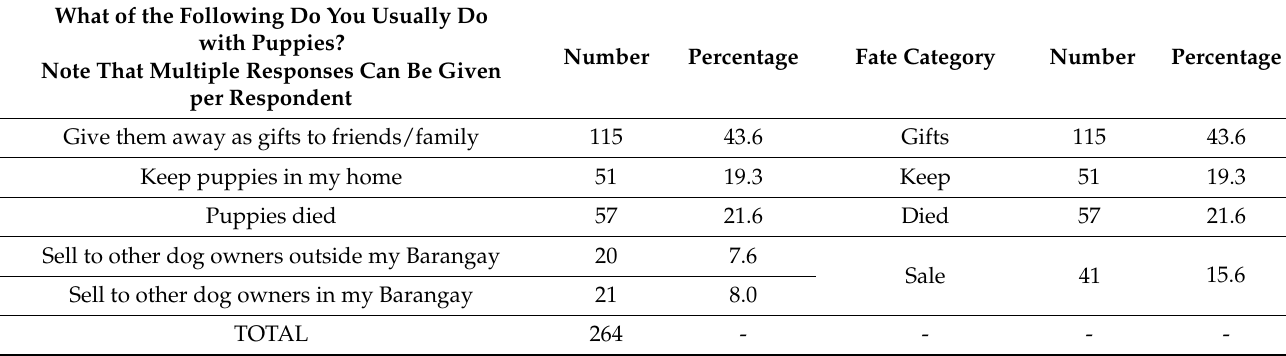
Table 5. Practices followed by pet owners for puppies born at their home in Quezon City.